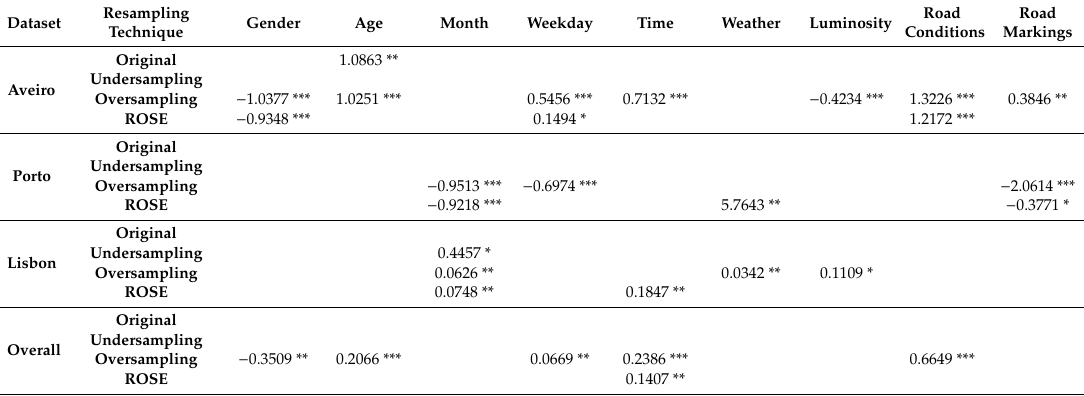
Table 6. Statistically significant variables for cyclists considering the logistic regression